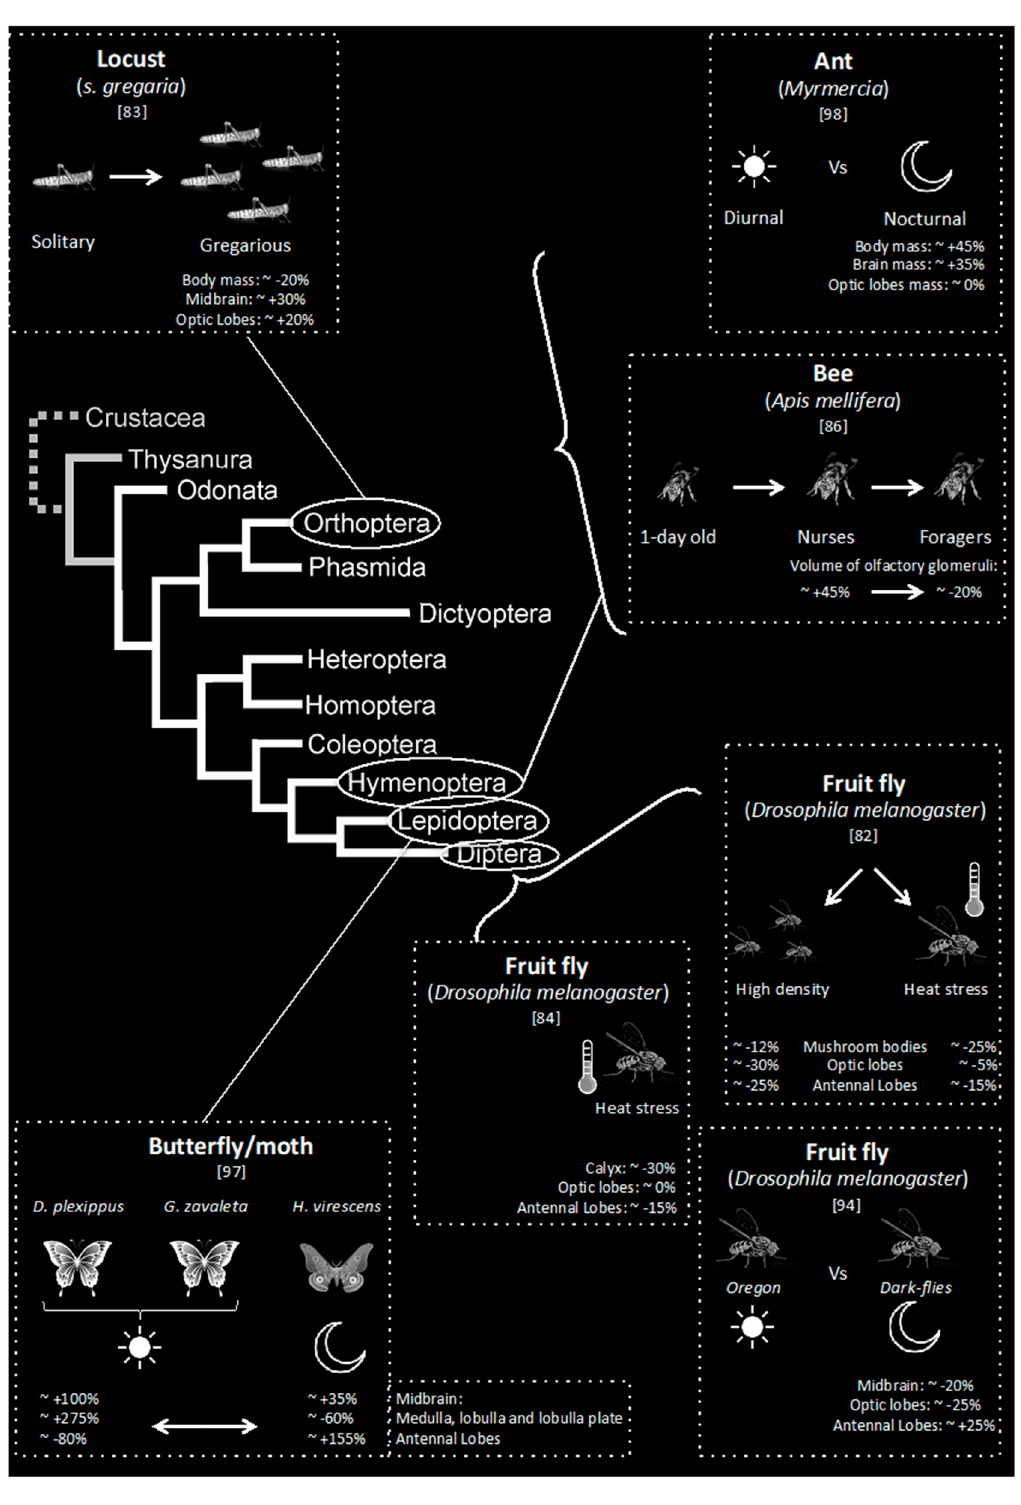
Figure 2. Examples of studies on influence of environment on brain size. In another type of population density, Ott and Rogers [82] showed that gregarious desert locusts have substantially larger brains compared with locusts in the solitarious phase (Figure 2). However, whereas larger sizes were observed in all sub-compartments (optic lobes, antennal lobes, midbrain, mushroom bodies, etc.), the relative size of optic lobes and antennal lobes reduced in size whereas the mushroom bodies (calyx and